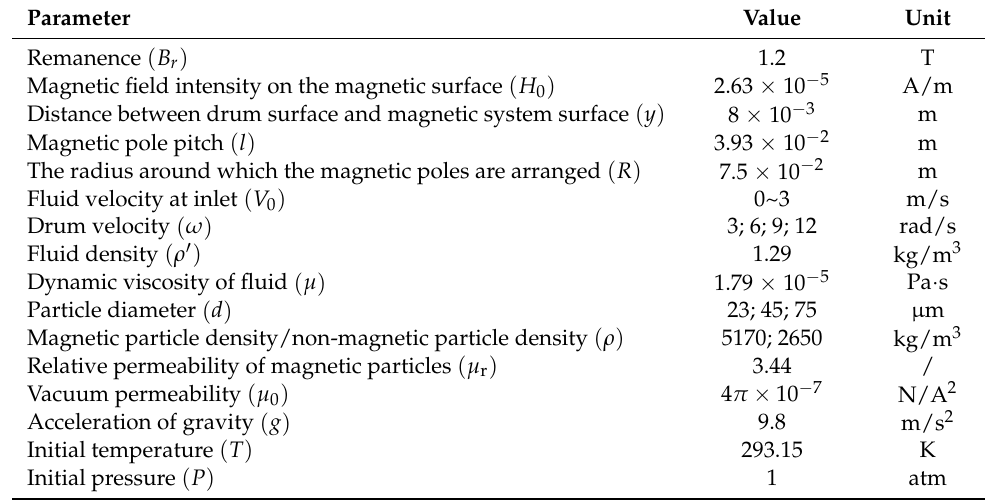
Table 1. Values of parameters for modeling calculation.